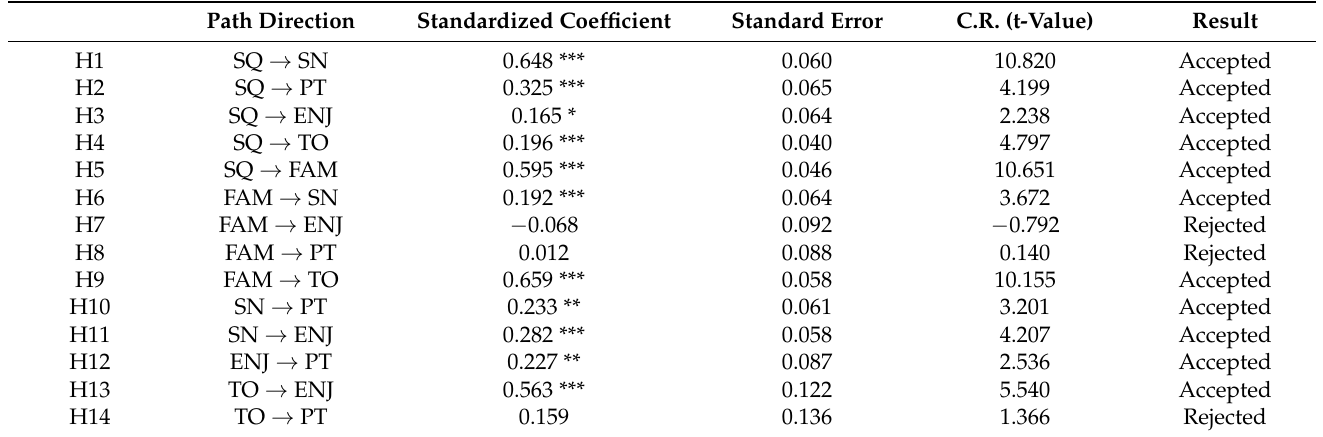
Table 6. Hypothesis